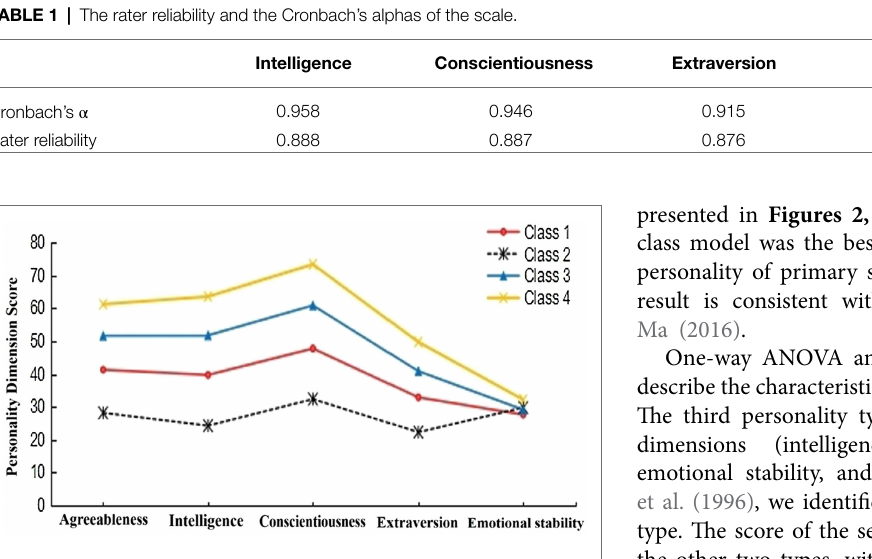
FIGURE 1 | Potential profile of the four-class model ( n 1 =